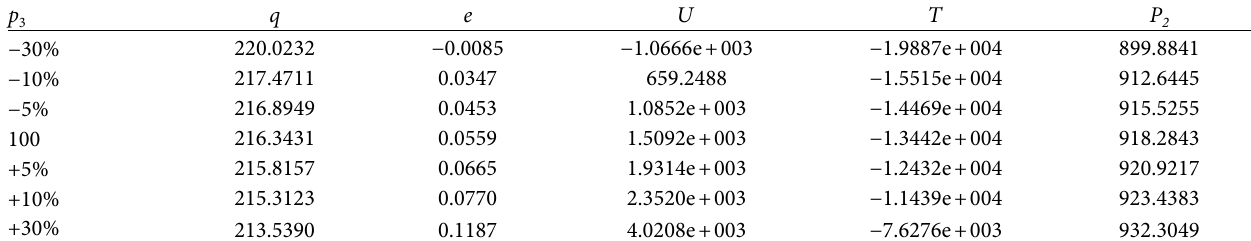
Table 4: Sensitivity analysis for the carbon trading price 𝑝